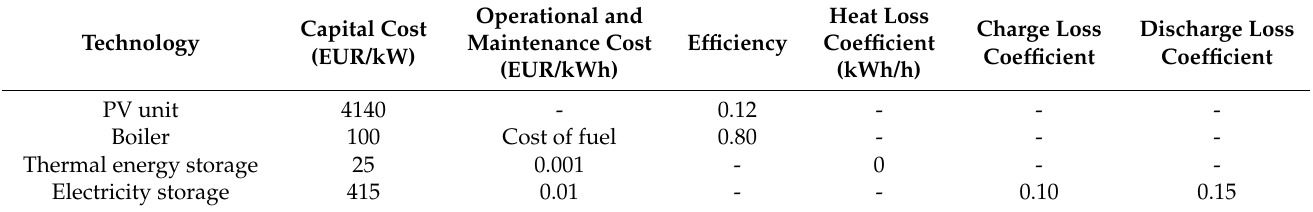
Table 5. Capacity, cost, and technical characteristics of other